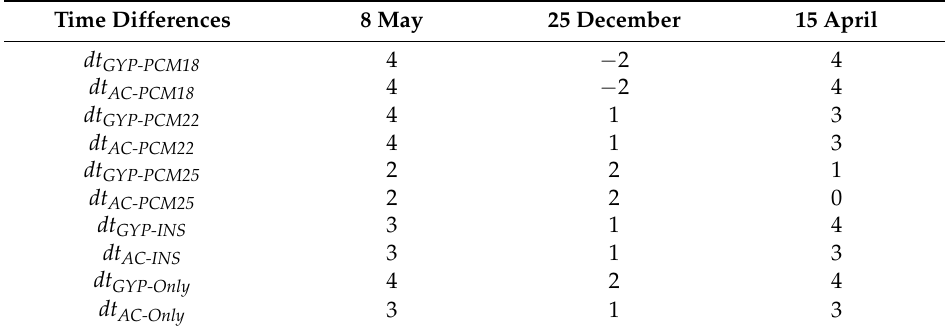
Table 9. Time differences between the time the maximum indoor temperature occurs and the time the maximum outdoor temperature occurs for each case scenario on 8 May, 25 December, and 15